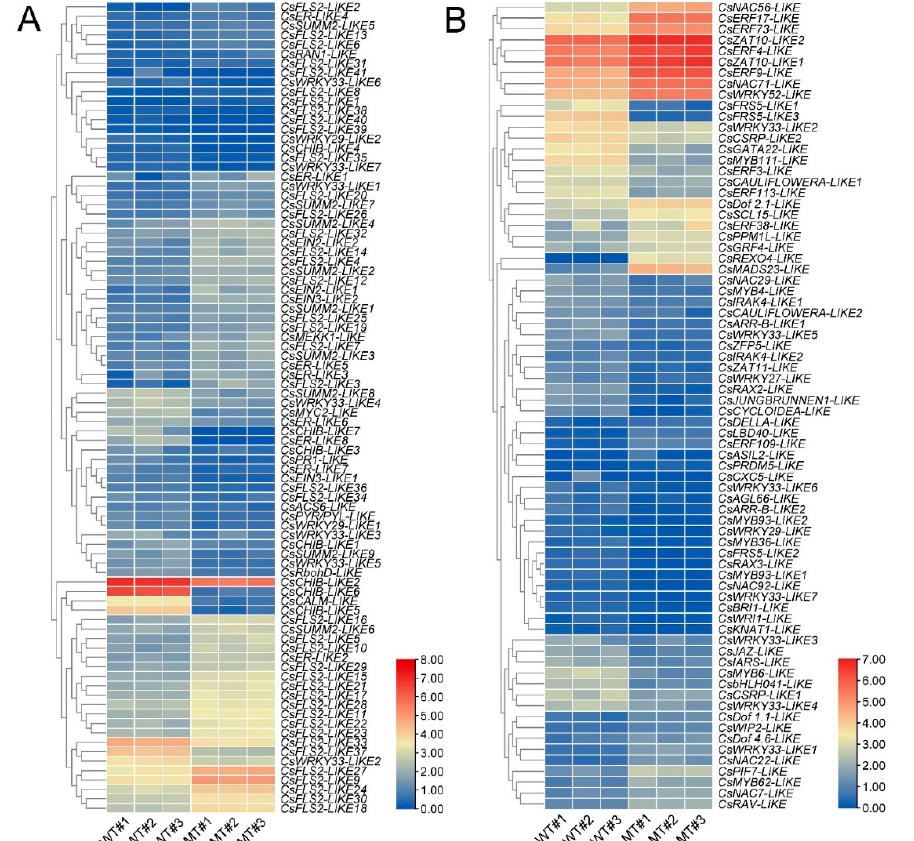
Figure 8. The heat maps show expression levels of differentially expressed genes (DEGs) involved in ( A ) the MAPK signaling pathway plant and ( B ) DEGs encoding transcription factors in WT and MT samples. The gradient color barcode indicates log 2 (FPKM+1) values in each sample.